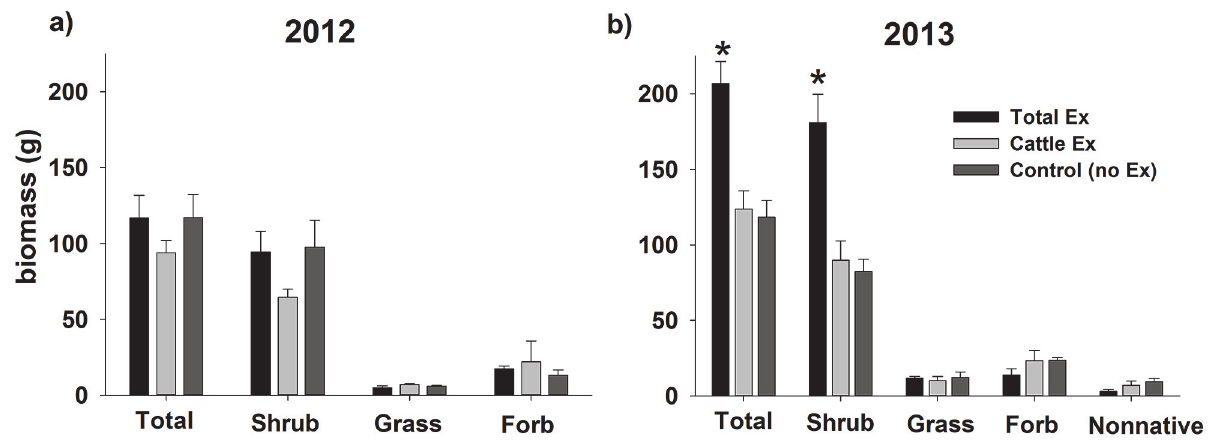
Fig 3. Plant Biomass. Mean biomass ± 1 S.E. in (a) 2012 and (b) 2013 of different plant growth forms (Total [i.e., all groups combined], Shrubs, Grasses, Forbs, and Non-natives) across three herbivore treatments. “ Total Ex ” denotes exclusion of large herbivore wildlife and cattle, “ Cattle Ex ” denotes exclusion of only cattle (but not wild herbivores), and “ Control ” denotes no exclusion i.e., access by both types of herbivore. Asterisks indicate treatment-year combinations that are significantly different (p < 0.10) than all other treatment-year combinations within a given plant growth form.